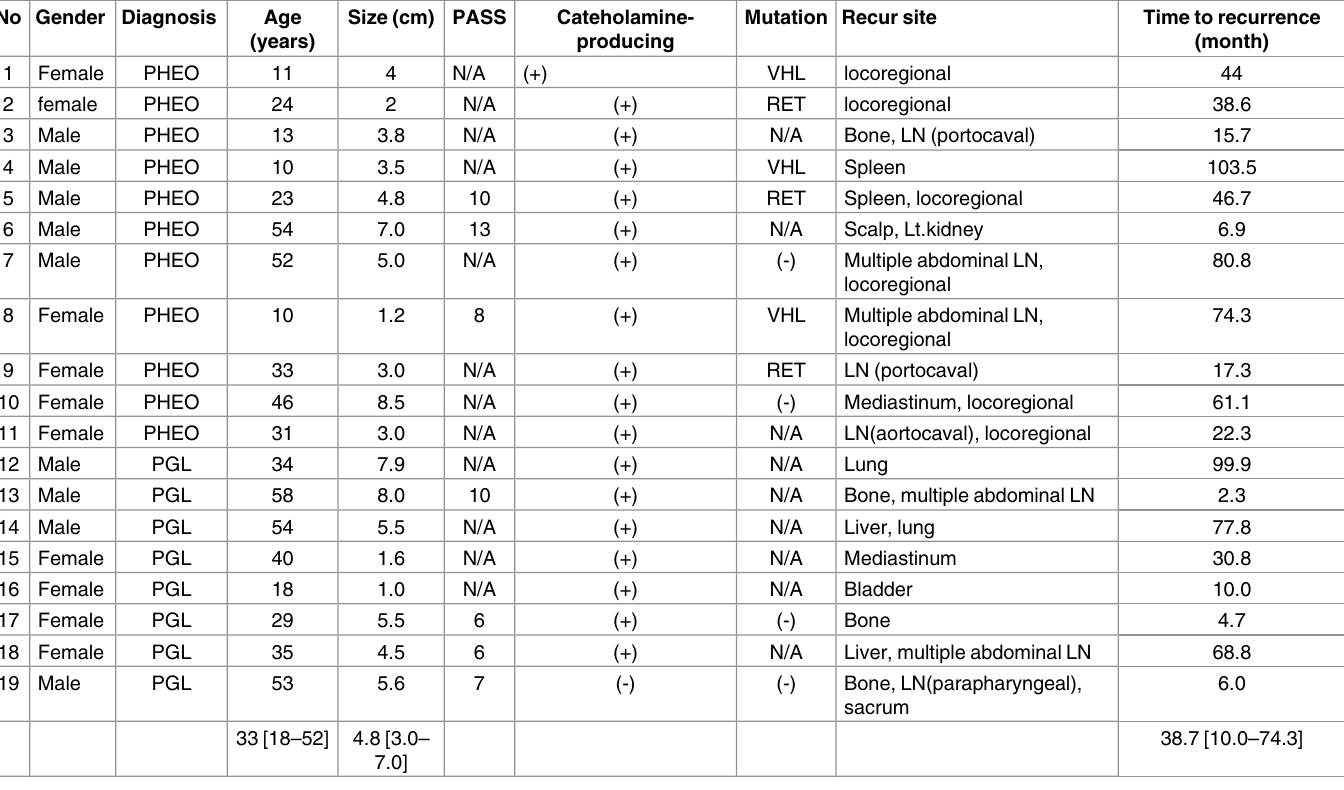
Table 4. Characteristics of PPGL patients with recurrence.